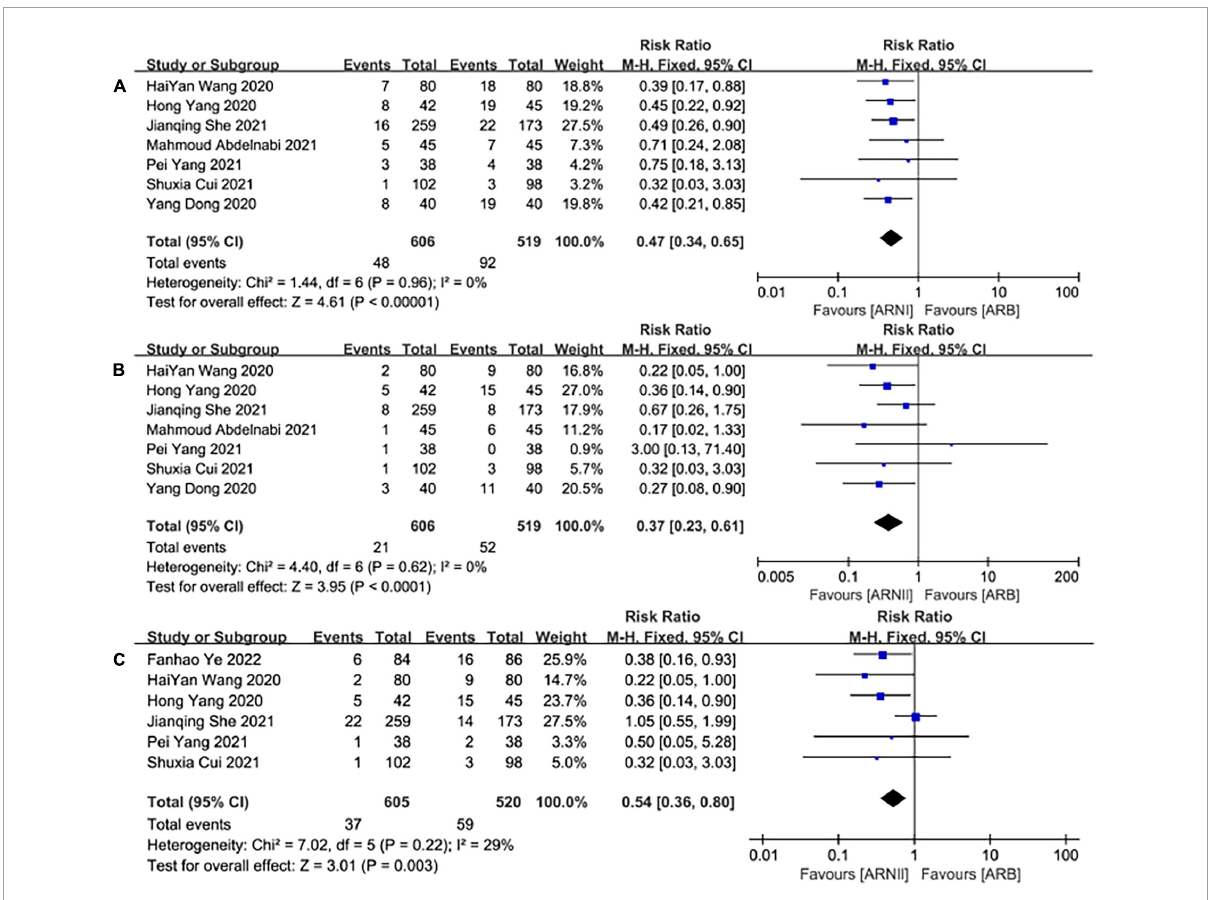
FIGURE11 The forest plots of the effectiveness and safety outcomes between early initiation of sacubitril/valsartan and angiotensin receptor blocker in patients after acute myocardial infarction (1). (A) The forest plots of the incidence of major adverse cardiac events, (B) the forest plots of the incidence of heart failure, and (C) the forest plots of the